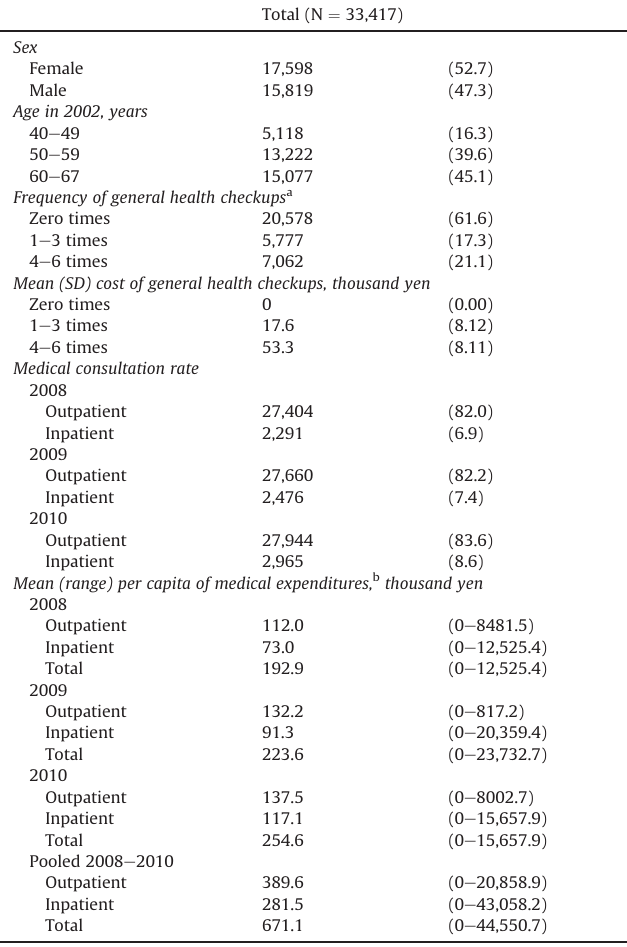
Table 1 Characteristics of study subjects.